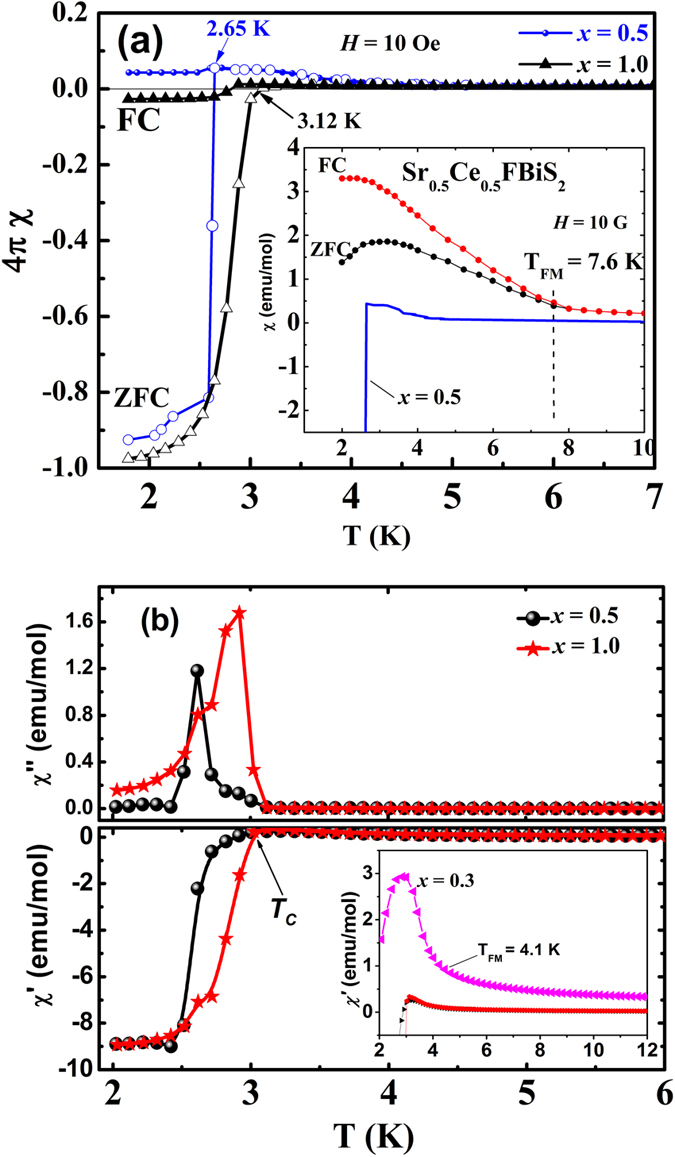
(a) Variable temperature dc susceptibility in ZFC and FC protocols for Sr0.5Ce0.5FBiS2-xSex (x = 0.5, 1.0) in an applied field of 10 Oe. Inset shows dc susceptibility for x = 0.0 sample in comparison with x = 0.5 sample in the same units (emu/mol) and (b) Real and imaginary parts of ac susceptibility for x = 0.5 and 1.0 samples. Inset shows ac susceptibility for x = 0.3 sample in comparison with x = 0.5 and 1.0 samples.